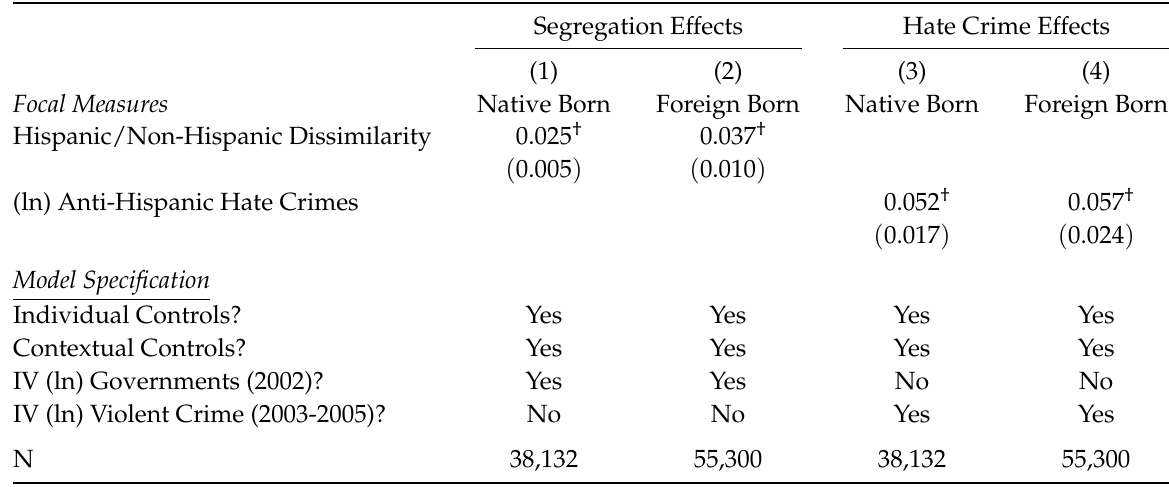
Table 3: IV Probit Estimates of Hispanic ’Other Race’ Identification by Nativity Status, American